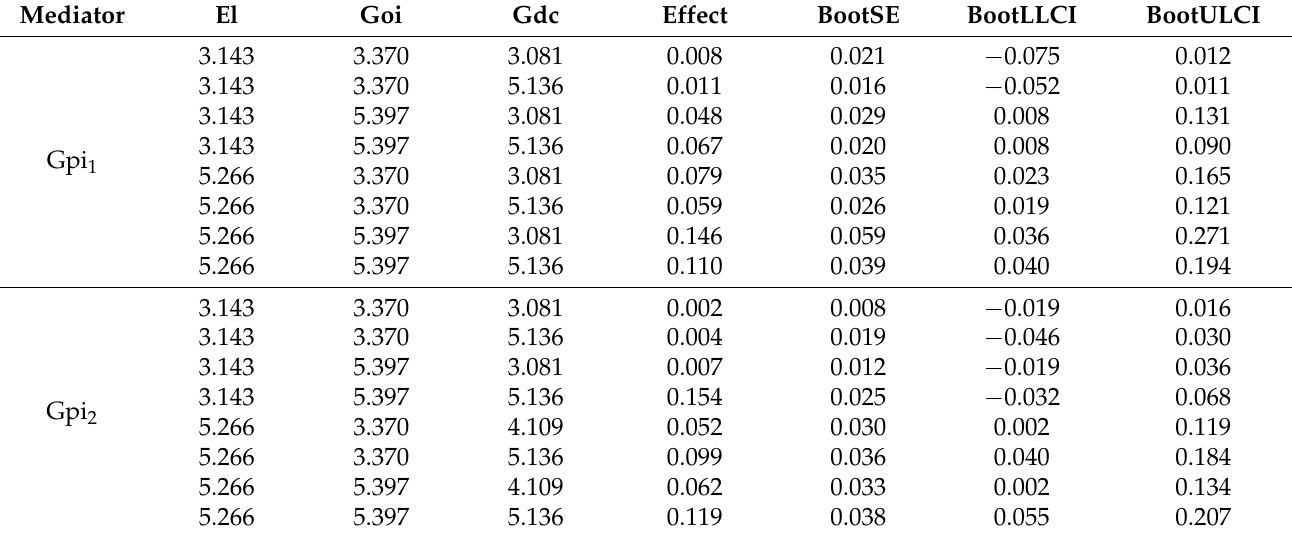
Table 7. The indirect effect under three